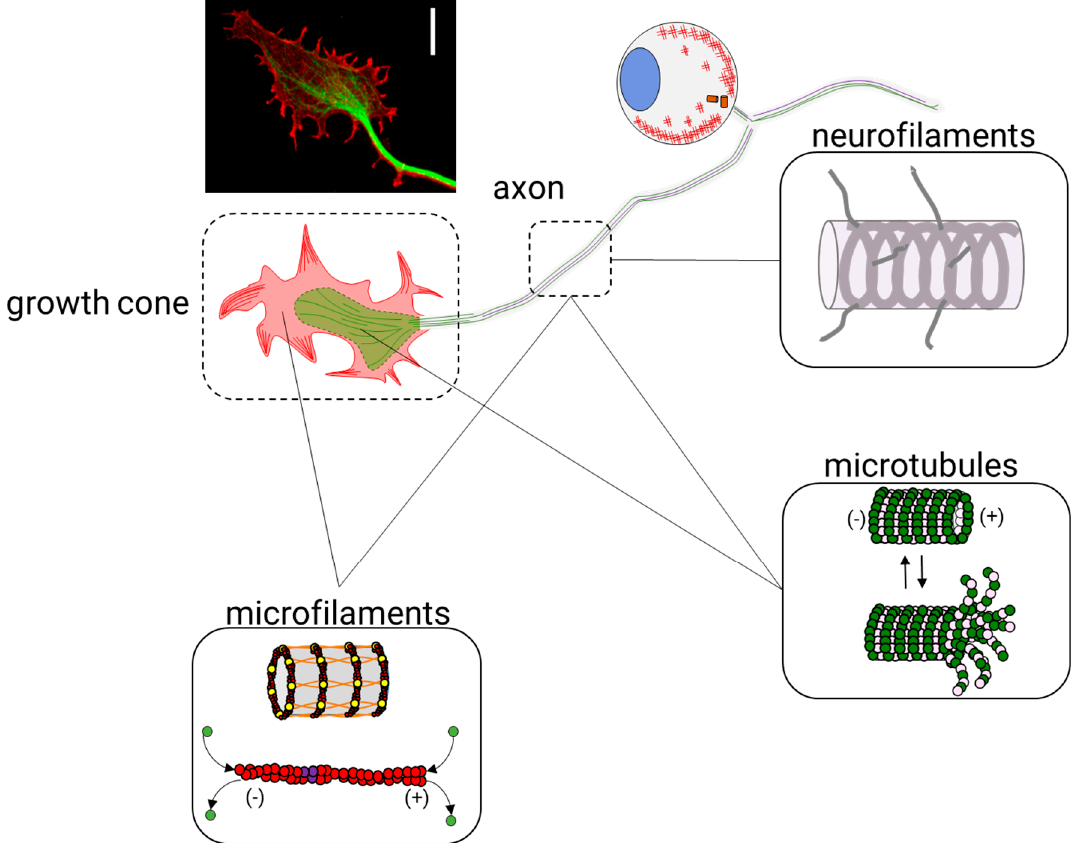
Figure 1. Main elements of the neuronal cytoskeleton. The neuronal cytoskeleton is mainly composed of neurofilaments, actin filaments, and microtubules. In neurons, actin filaments and microtubules are very dynamic in response to physiological needs, for example, during the embryonic development of the nervous system and the axonal regeneration of peripheral nerves after damage. Here, neurons need to grow a new axon and direct it to their right target. For this particular task, neurons use the growth cone, a motile structure rich in actin and microtubules as well as other cytoskeletal components. Scale bar 10 μ m.